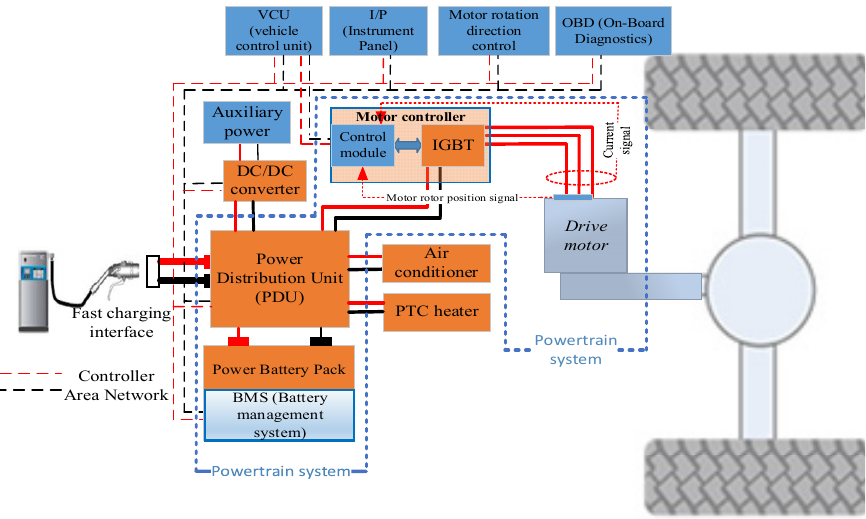
Figure 2. Structural diagram of powertrain system in a BEV.